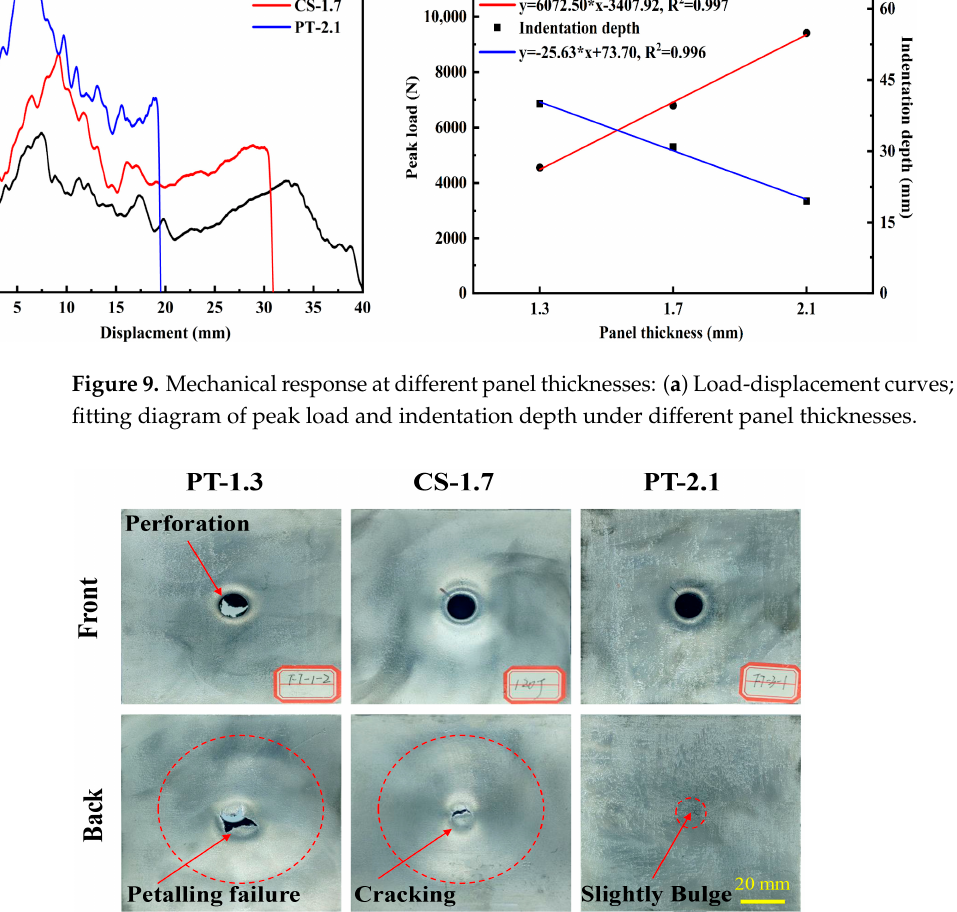
Figure 10. Failure modes of panels of AFS with different panel thicknesses.